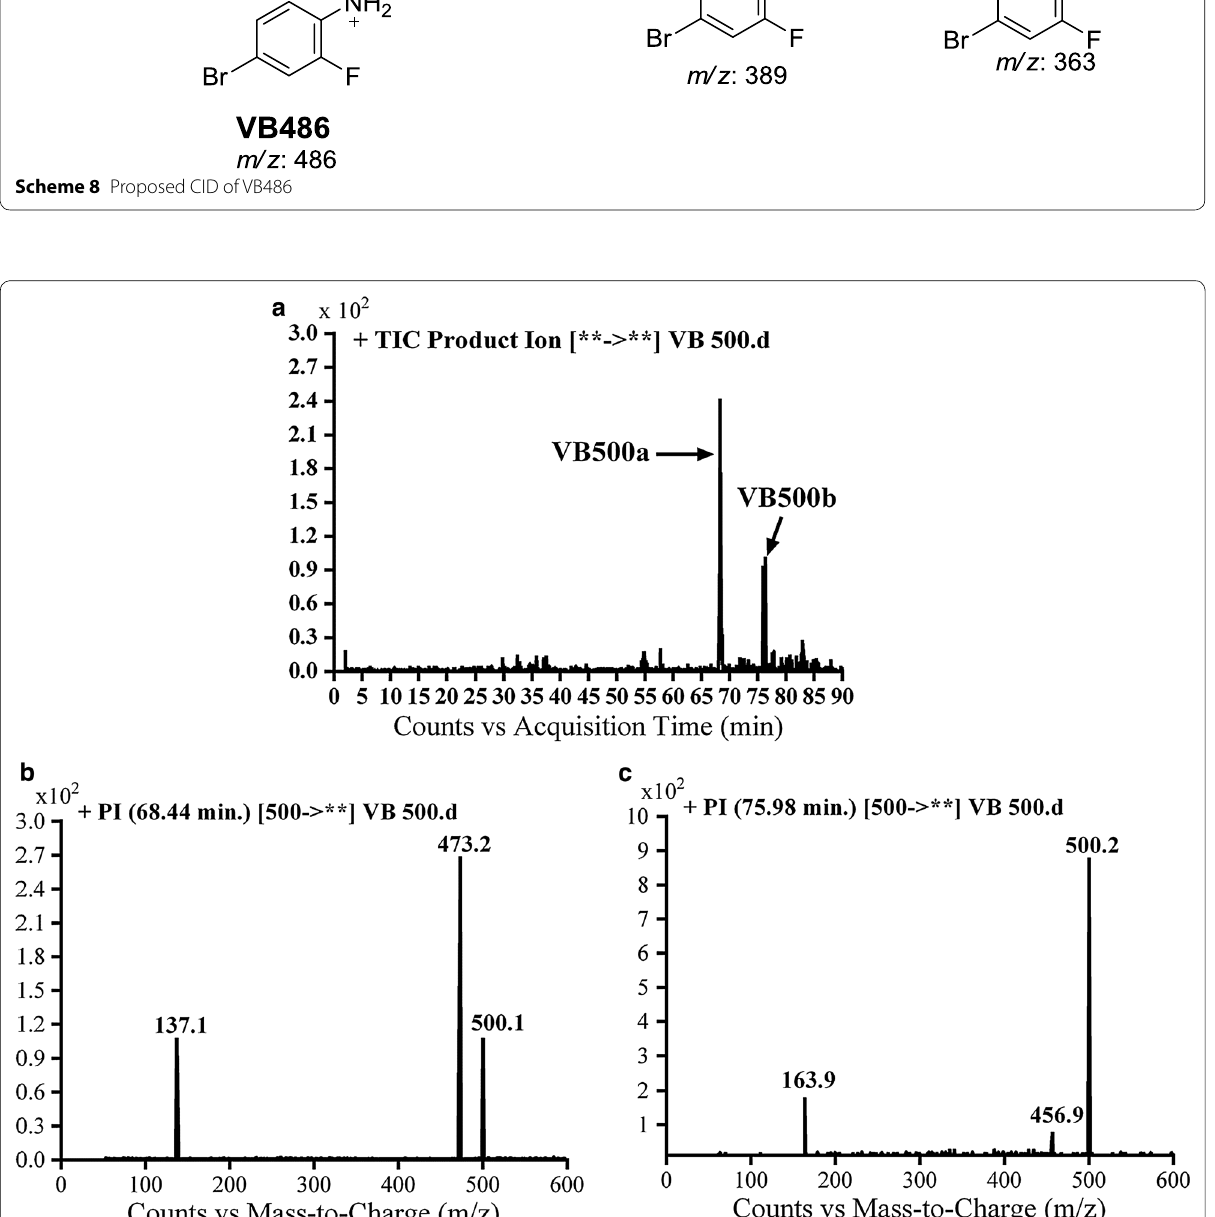
Fig. 6 PI chromatogram of MIP at m/z 500 showing two peaks: VB500a (68.4 min) and VB500b (75.9 min) ( a ), PI mass spectra of VB500a ( b )